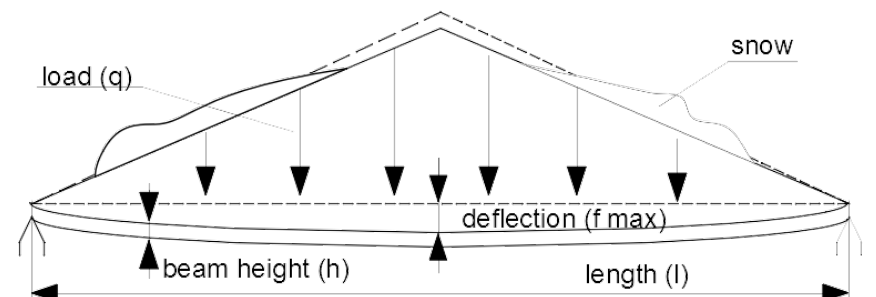
Figure 7. Changing dimensions of the roof under load, solid line: size under load of snow, dash line: size without load.